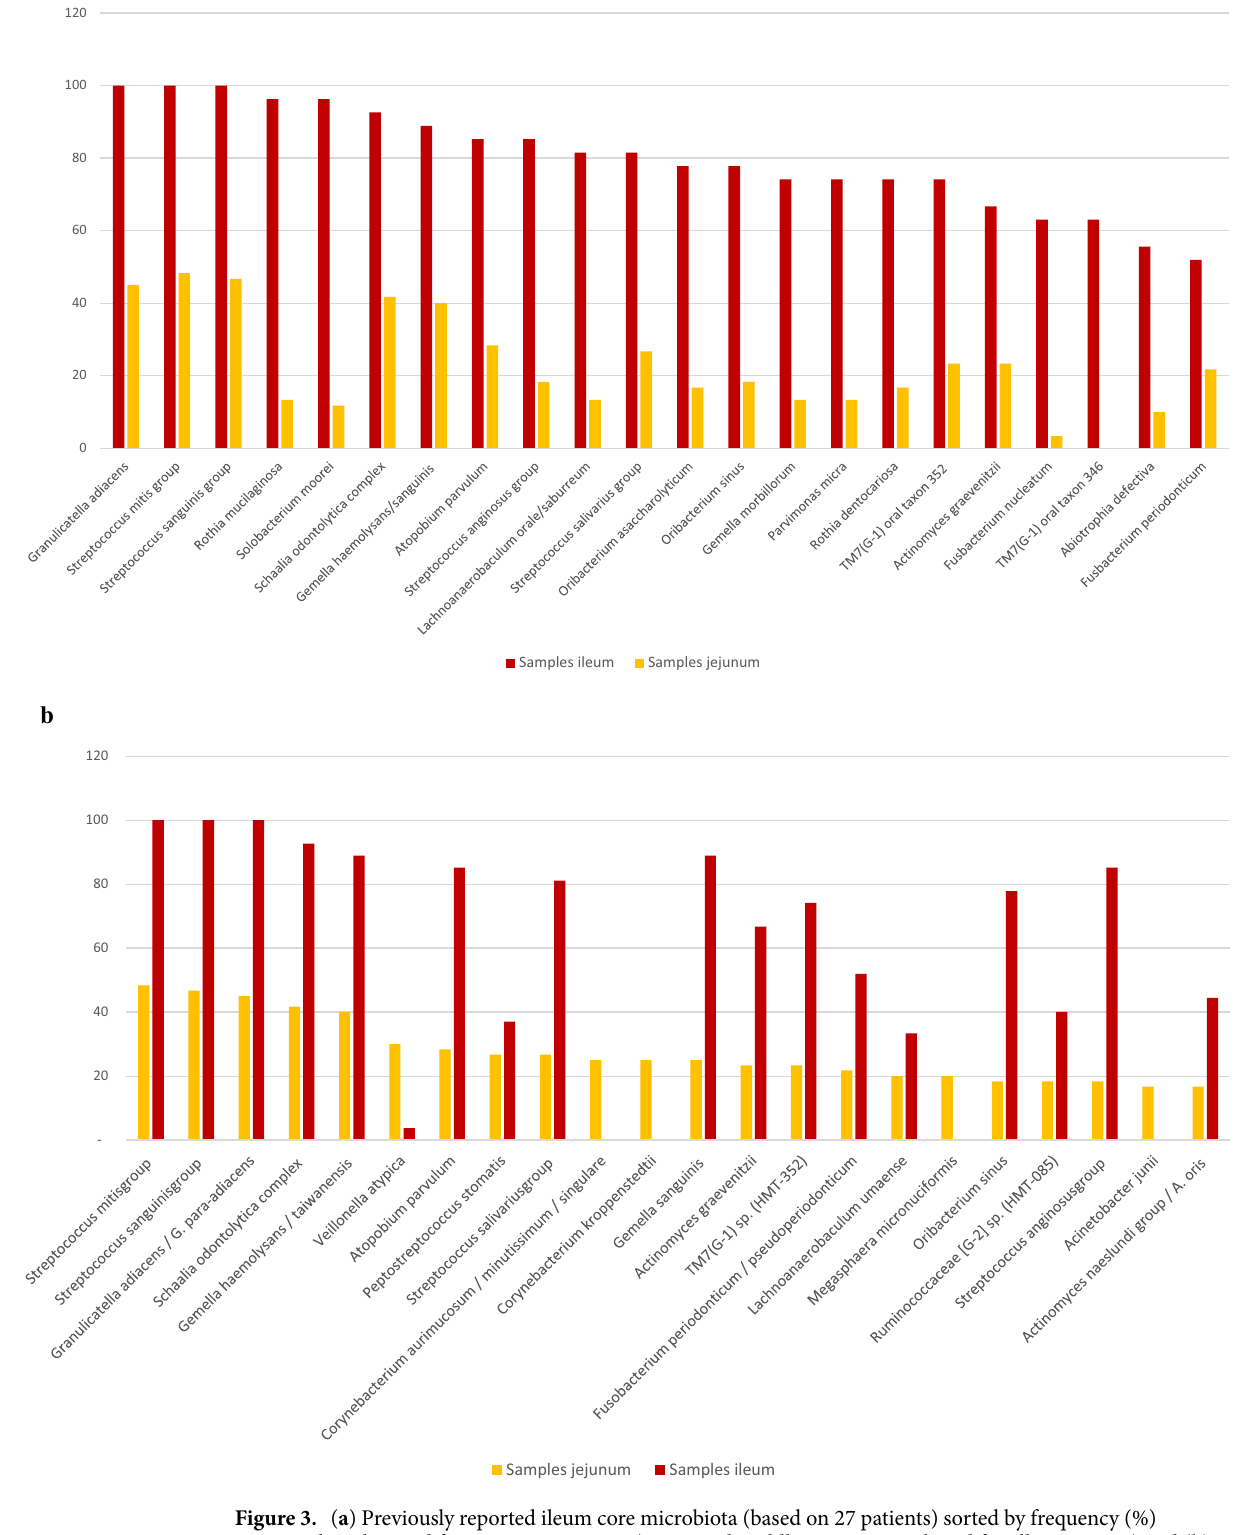
Figure 3. ( a ) Previously reported ileum core microbiota (based on 27 patients) sorted by frequency (%) compared to observed frequency in jejunum (upper and middle segment combined for all 60 patients) and ( b ). Most frequently detected species in jejunum (upper and middle segment combined) sorted by frequency (%) compared to previously reported frequency in ileum. Based on all 60